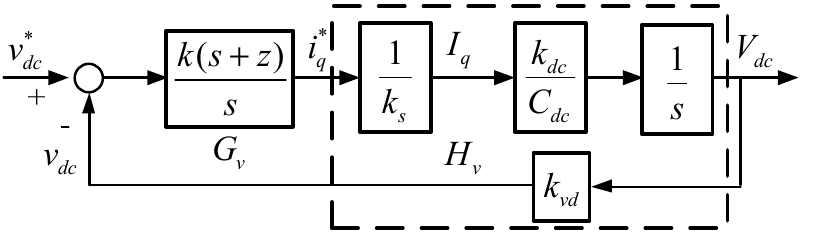
Figure 8. Control loop of DC link voltage controller.